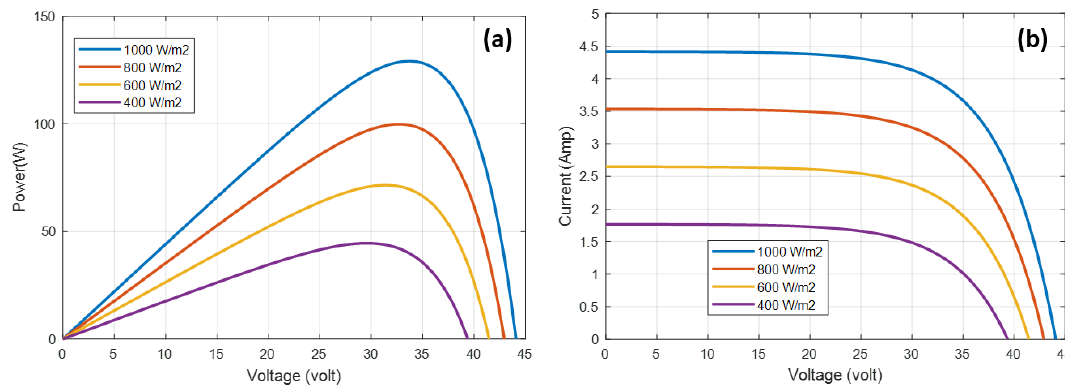
Figure 2. The e ff ect of the ambient conditions on the power and electric current values. ( a ) P–V curves and ( b ) I–V curves for di ff erent irradiance values at 25 °C.